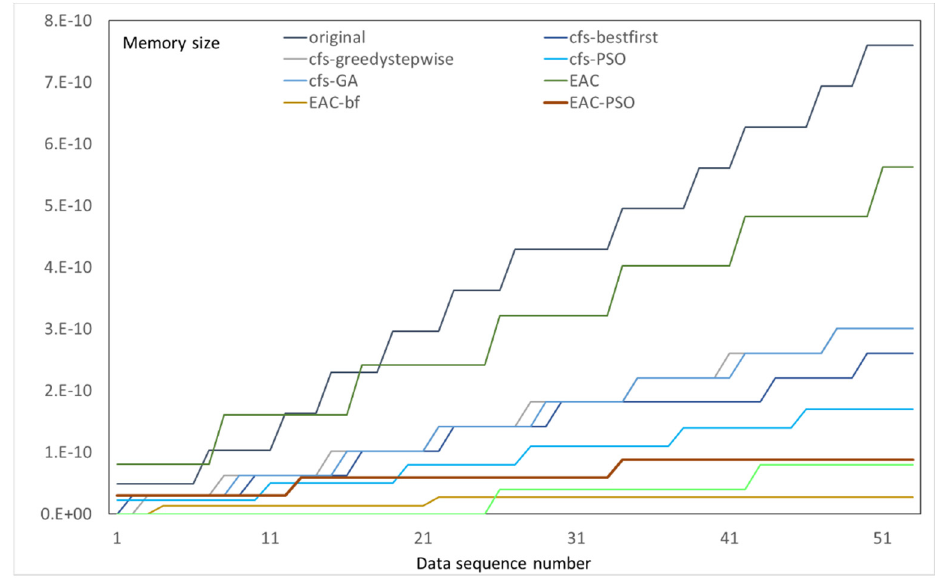
Figure 10. Comparative graph of memory of the Hoeffding tree model coupled with seven prepro- cessing algorithms.